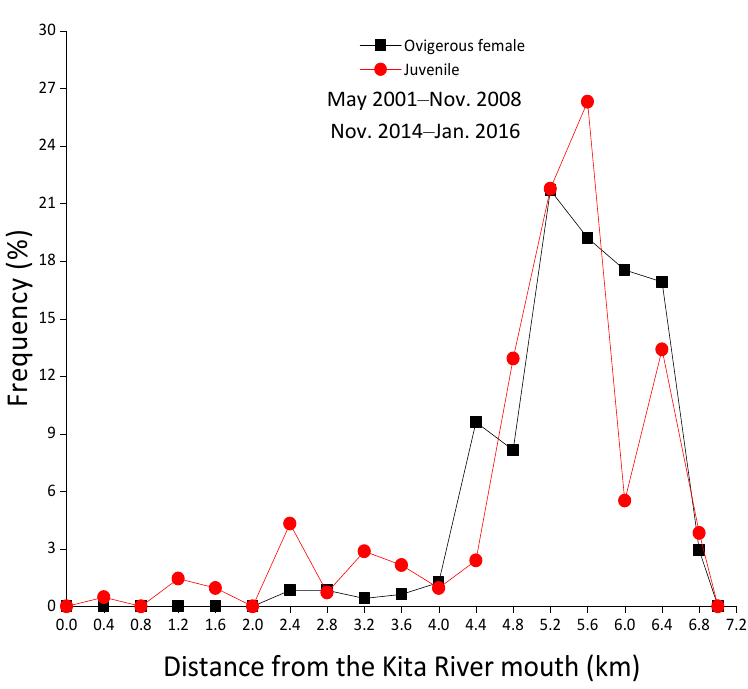
Figure 8. Frequency of young juveniles and ovigerous females by distance from the Kita River mouth during the sampling periods.